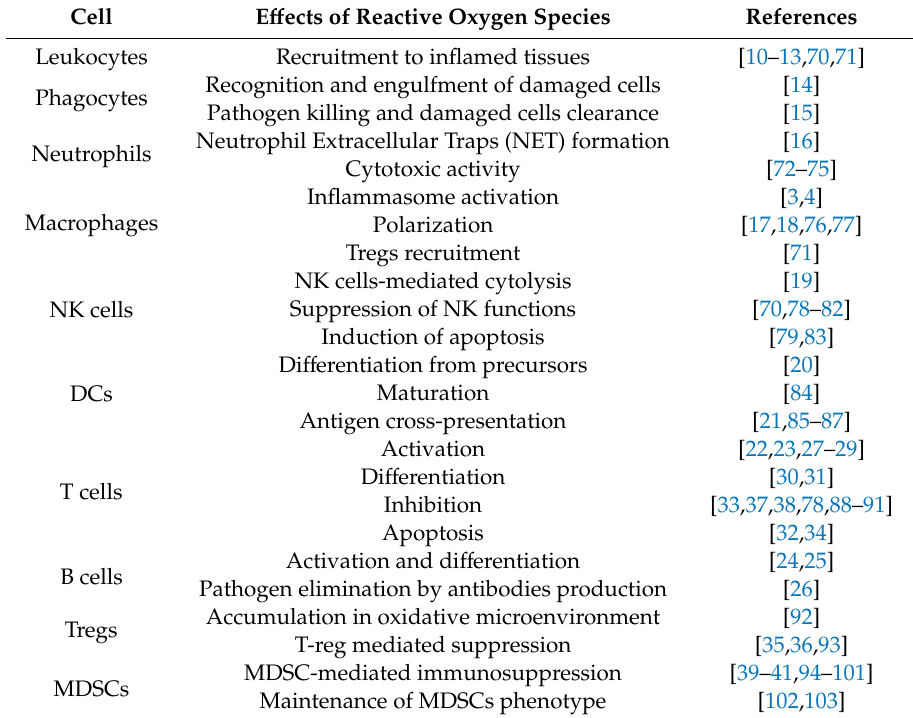
Table 1. Summary of ROS Functions and E ff ects on Immune